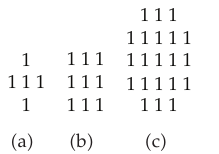
Figure 2: The structure templates of (cid:2) a (cid:3) rhombus, (cid:2) b (cid:3) square 3 × 3 and (cid:2) c (cid:3)